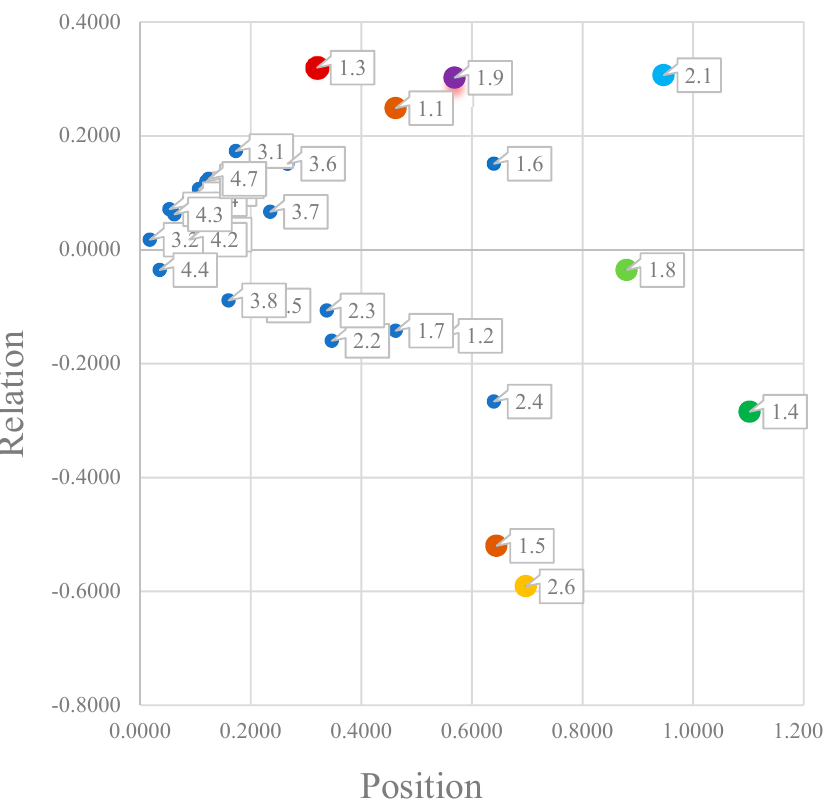
Figure 2. Graphical illustration of results in the relation—position coordinates.